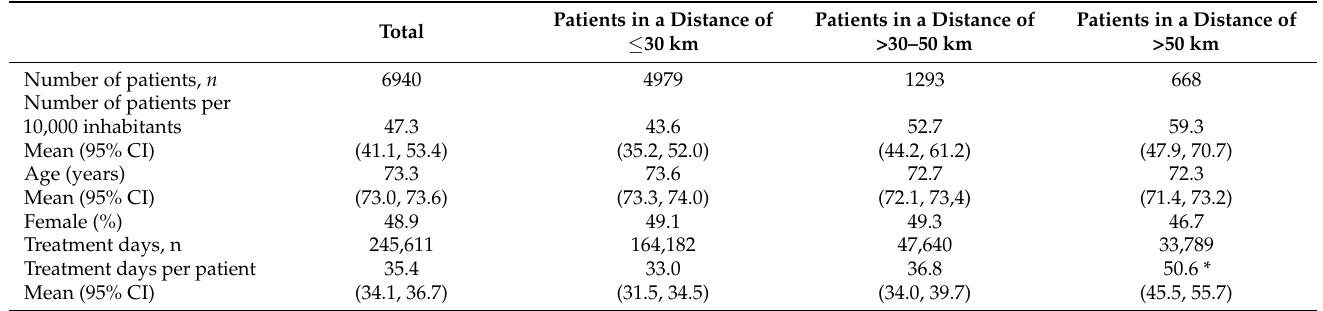
Table 2. Number of SAPV patients and treatment days, differentiated by distance to the treating SAPV team’s site (2014–2017).